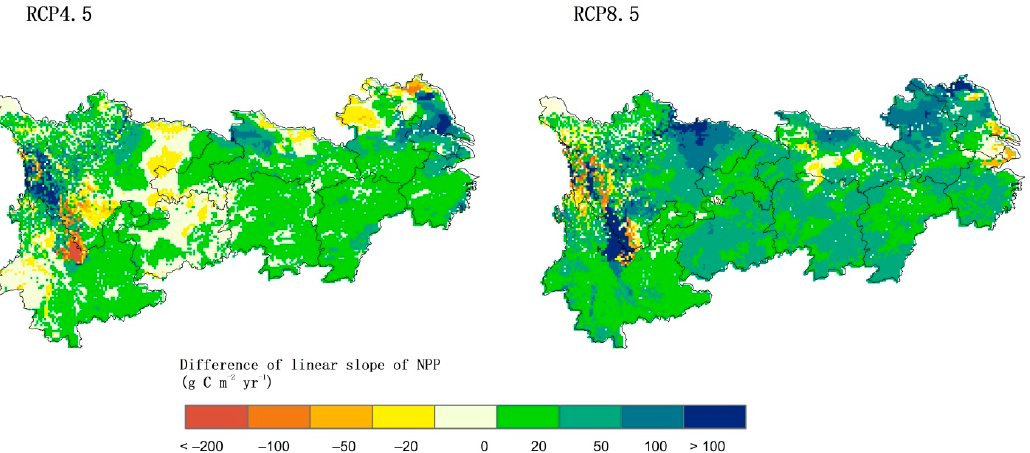
Figure 8. Spatial patterns of NPP trends at 1.5 and 2 ◦ C global warming targets under the RCP4.5 and RCP8.5